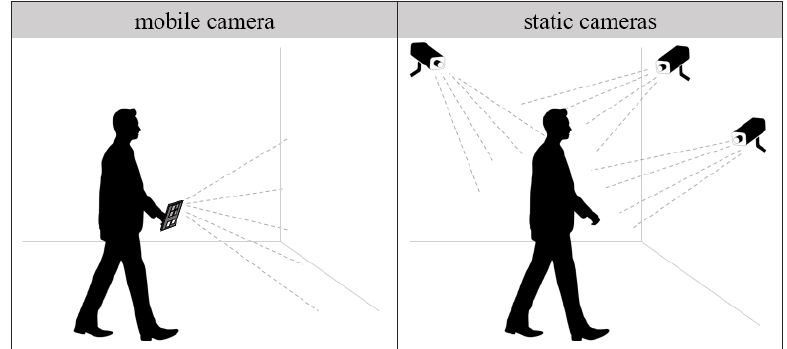
Figure 1. Indoor localization with a mobile camera ( left ) or with static cameras ( right